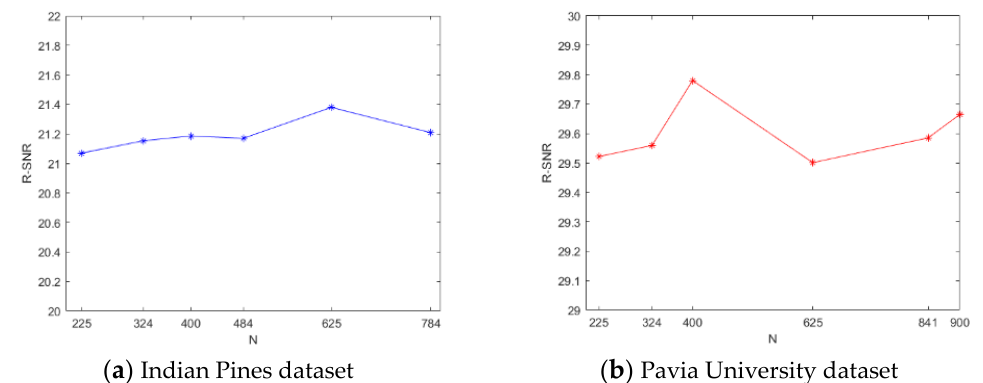
Figure 10. R-SNR varies with different N on two datasets.